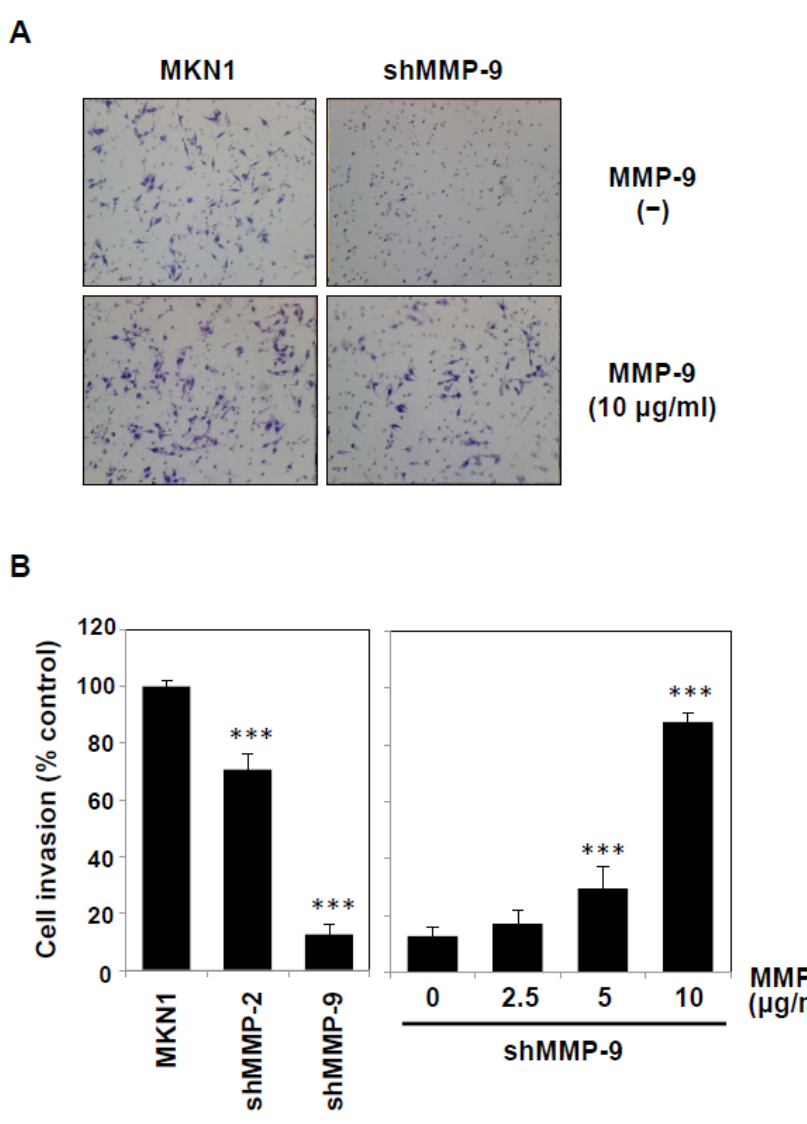
Figure 6. Potentiation of the invasion of MMP-9-knockdown MKN1 cells by exogenous MMP-9. MMP-2- or MMP-9-knockdown MKN1 cells were prepared by RNA interference as described in the Materials and Methods section. ( A ) The MMP-9-knockdown MKN1 cells ( right ) and parent cells ( left ) were assayed for in vitro invasion using Matrigel basement membranes in the presence or absence of MMP-9 purified from THP-1 cells. After culturing for 16 h, the cells that had migrated into the lower chamber were microscopically observed (40 × ). ( B ) MMP-2- or MMP-9-knockdown MKN1 cells were subjected to an invasion assay, and the migrated cells were counted under a microscope ( Left ). The invasion assay was performed in the presence of purified MMP-9 (2.5–10 µ g/mL) ( right ). Experiments were performed in triplicate, and the data are presented as the mean ± SEM. Statistical data analysis was conducted using the Student’s t -test. *** p < 0.005.